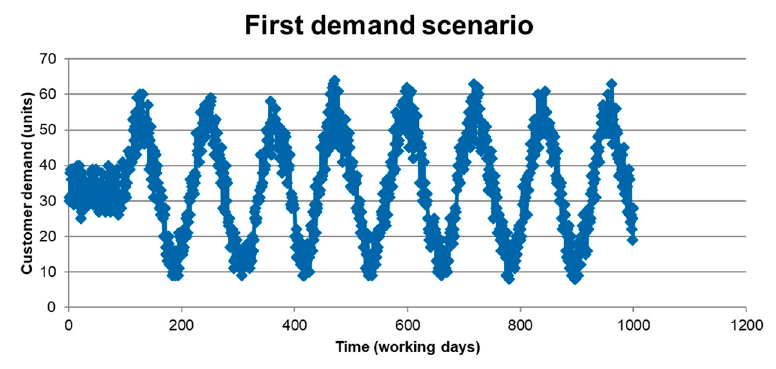
Figure 6. First demand scenario—probable scenario (own elaboration).